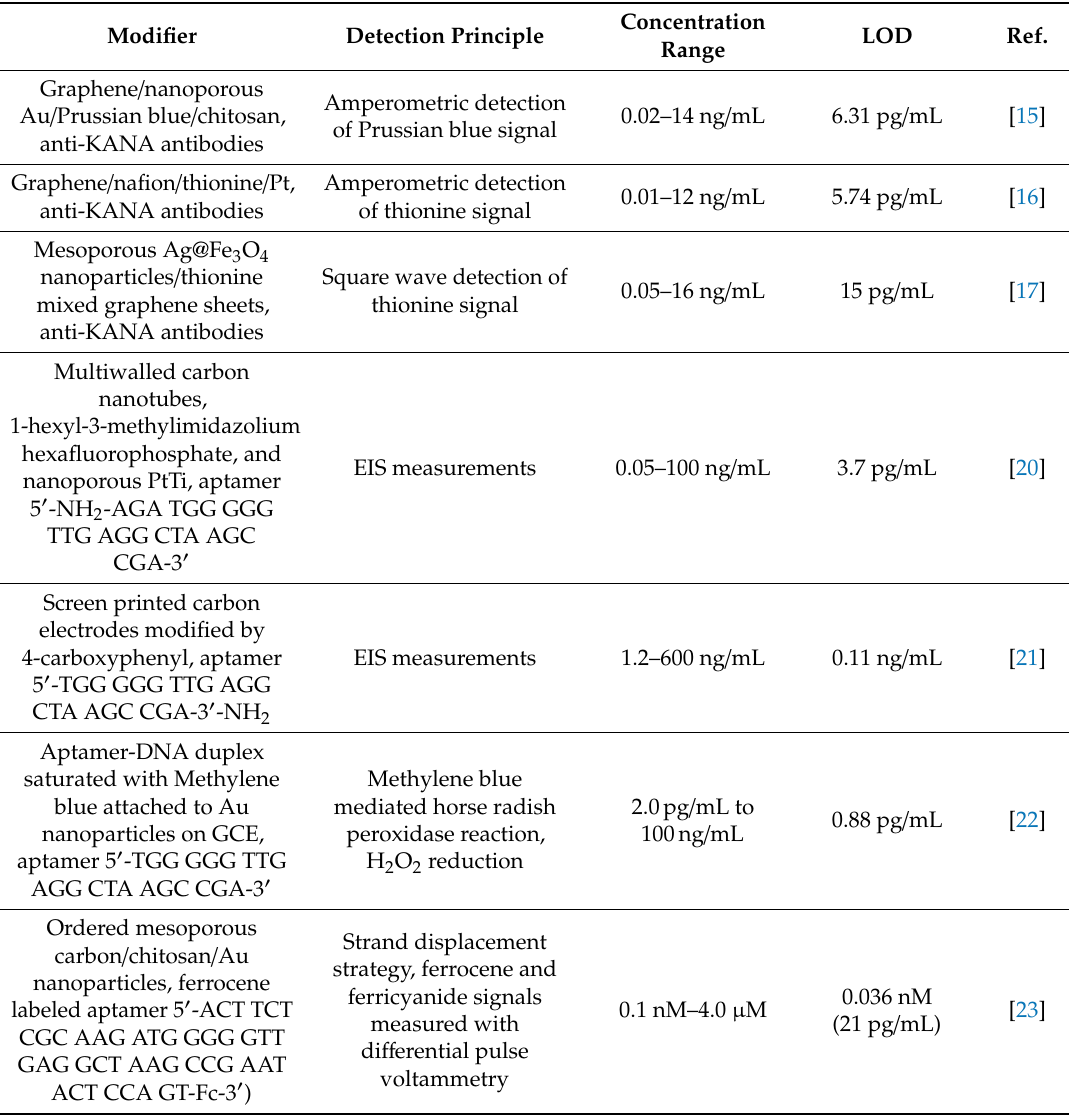
Table 2. Analytical characteristics of KANA determination with electrochemical immuno- and aptasensors. Fc—ferrocene, MB—Methylene